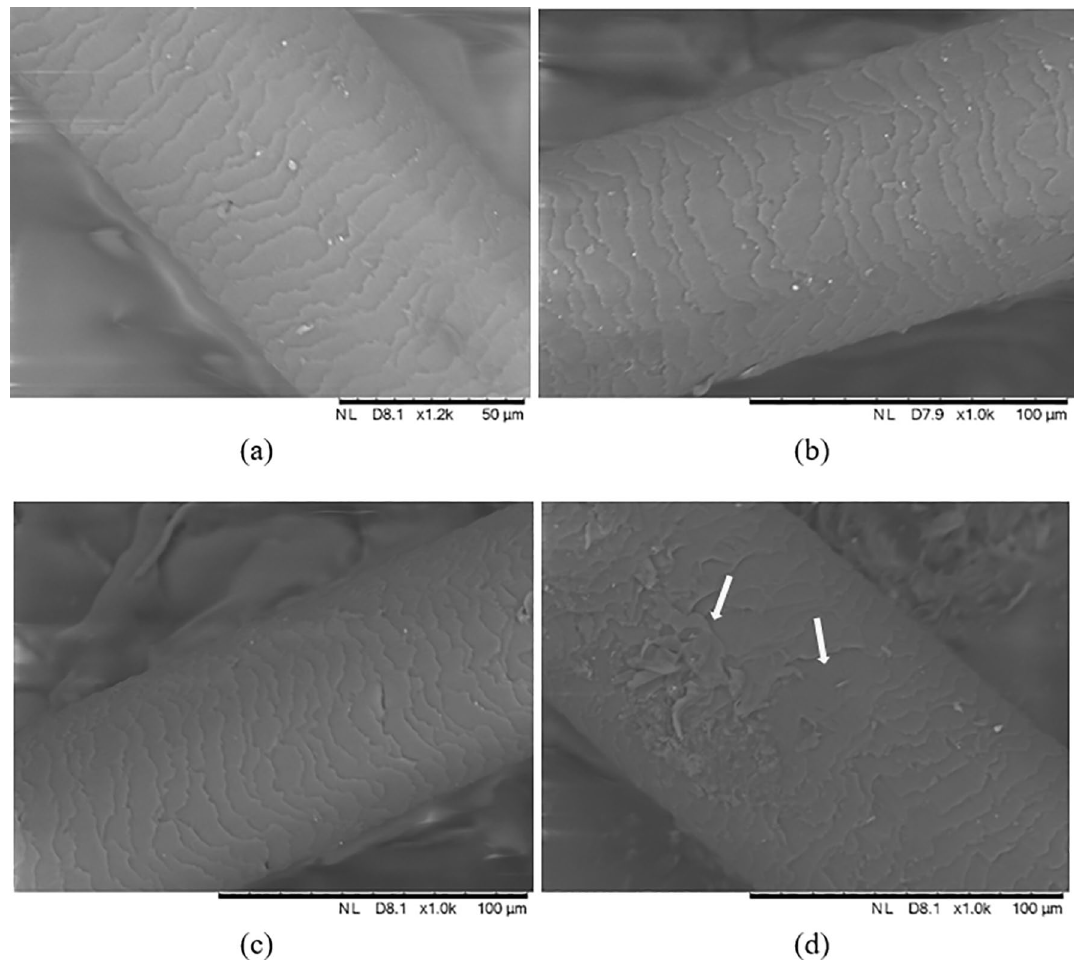
Figure 2. SEM images of the samples of hair, pertaining to: ( a ) non-irradiated hair and hair irradiated to doses of ( b ) 10 Gy, ( c ) 50 Gy and ( d ) 200 Gy. The arrows in ( d ) indicate irregularity of the cuticle scales pattern, seen at the highest dose level used